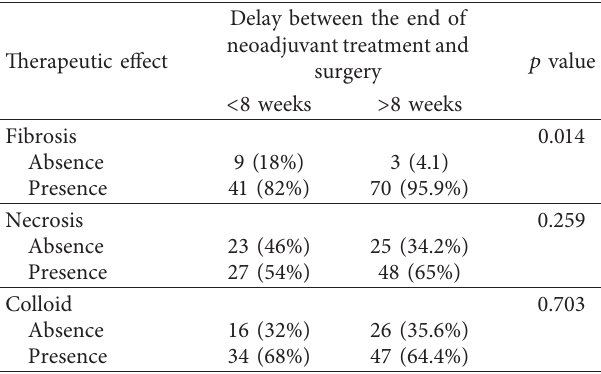
Table 3: The effect of neoadjuvant to surgery interval on the therapeutic effect